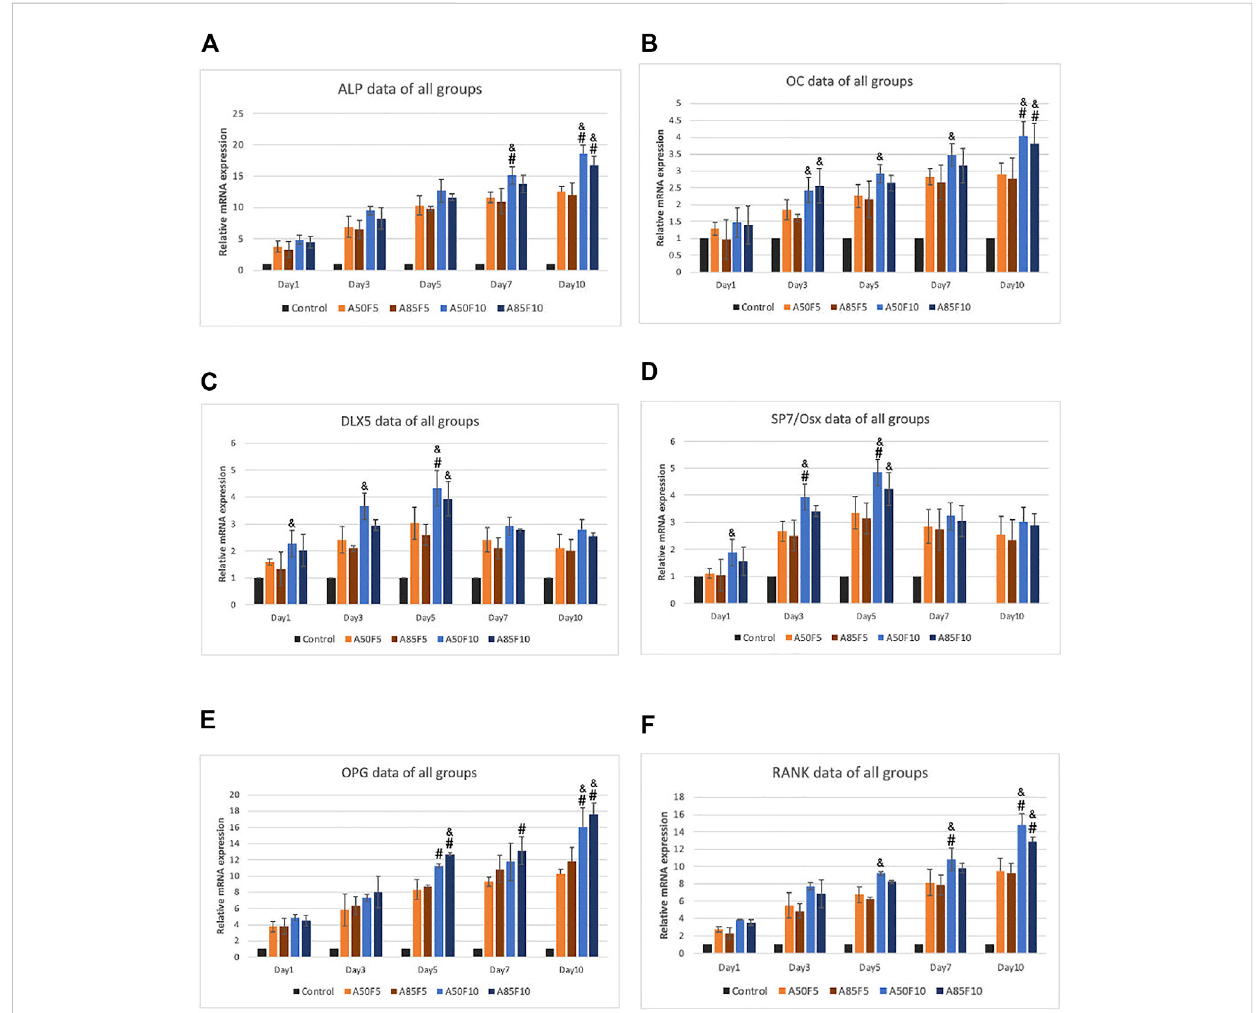
FIGURE 12 RT-qPCR data of all sample groups demonstrating increased upregulation of osteogenic related mRNA expression and A50F10 showed highest expression for (A) ALP, (B) OC, (C) DLX5, (D) SP7and (F) RANKwhileA85F10 hadhighestexpressionfor (E) OPG primers, (Signi fi cantdifferencecompared withcontrolisindicatedwith*, p < 0.05,**, p < 0.005,and***, p < 0.001while#symbolforcomparingwithA50F5,&symbolisappliedforcomparingwith